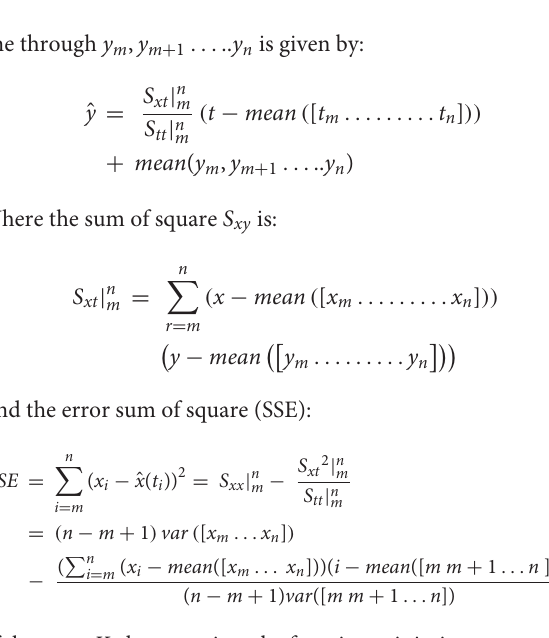
line through y m , y m + 1 . . . .. y n is given